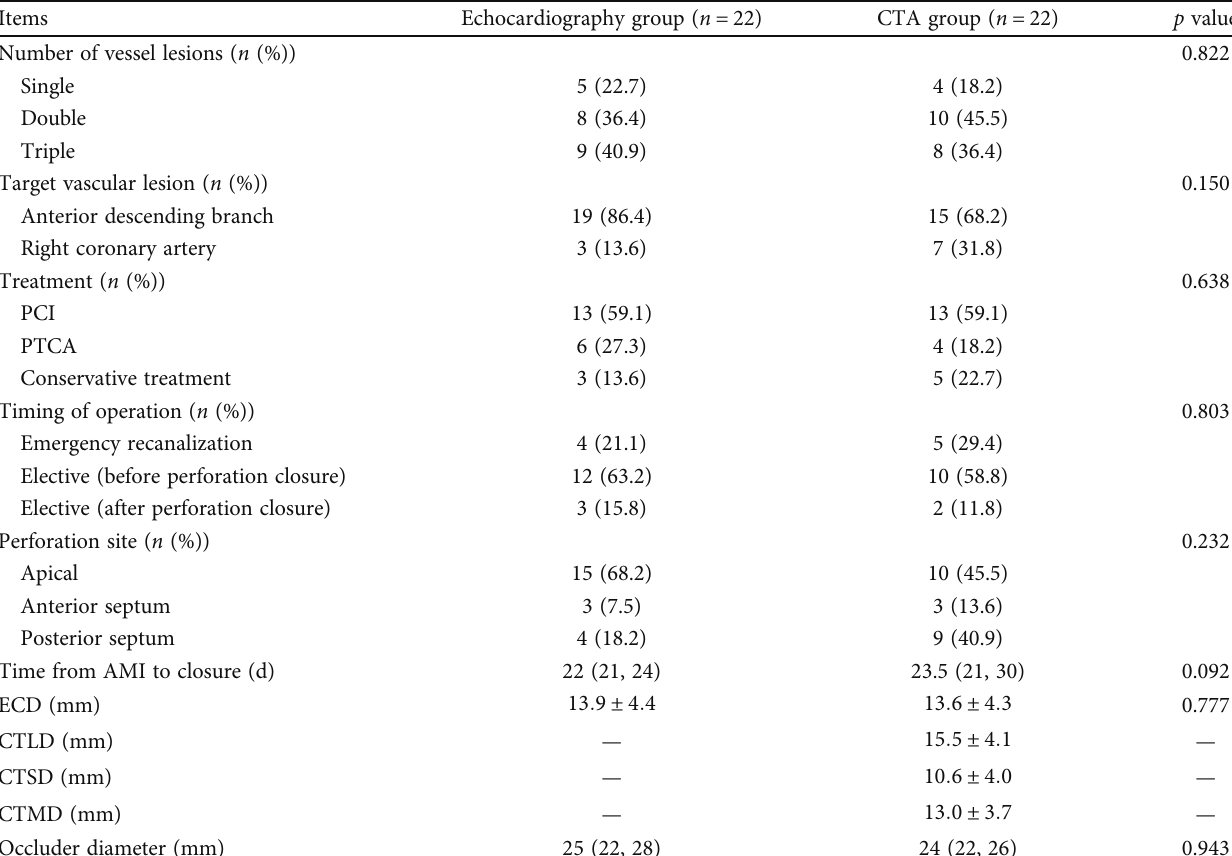
Table 2: Comparison of coronary artery lesions and VSR between the echocardiography group and CTA group.